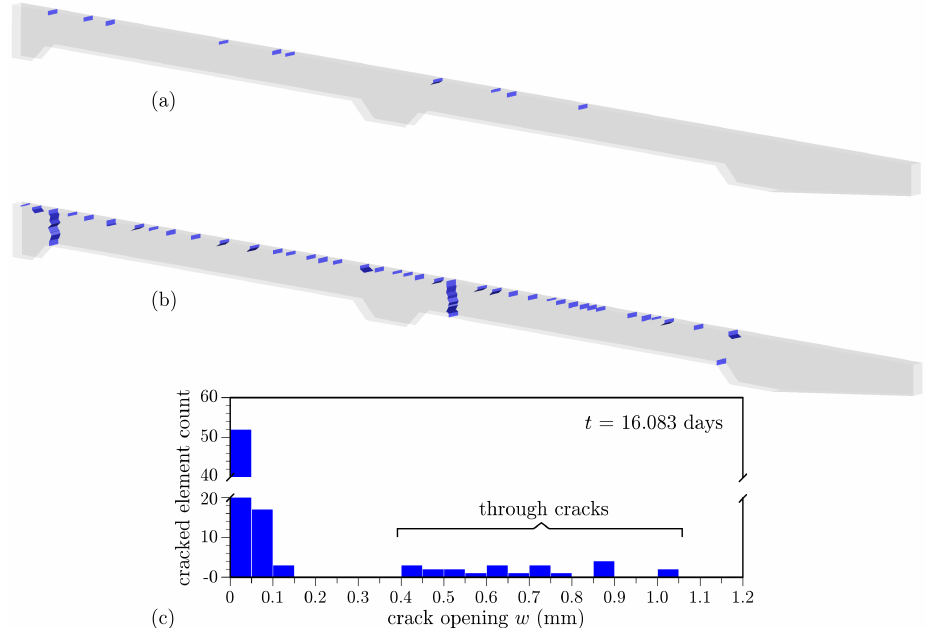
Figure 26. Simulated deck cracking: ( a ) without restraint; ( b ) with restraint associated with an internal diaphragm; and ( c ) crack opening histogram for the restrained case (at 12pm on Day